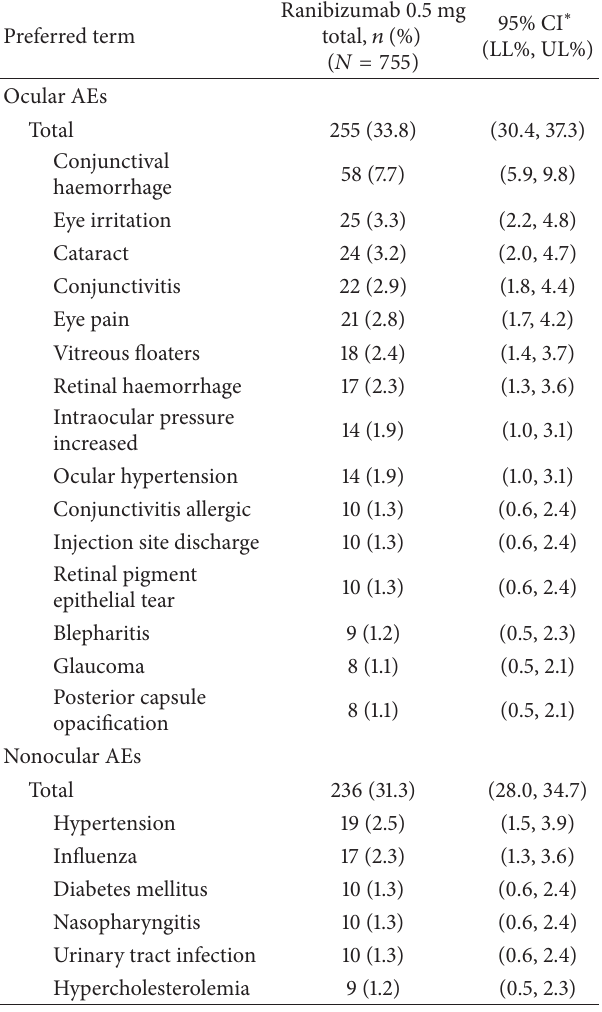
Table 6: Patients with frequent ( ≥ 1%) ocular and nonocular AEs over 2 years (safety set, first-treated